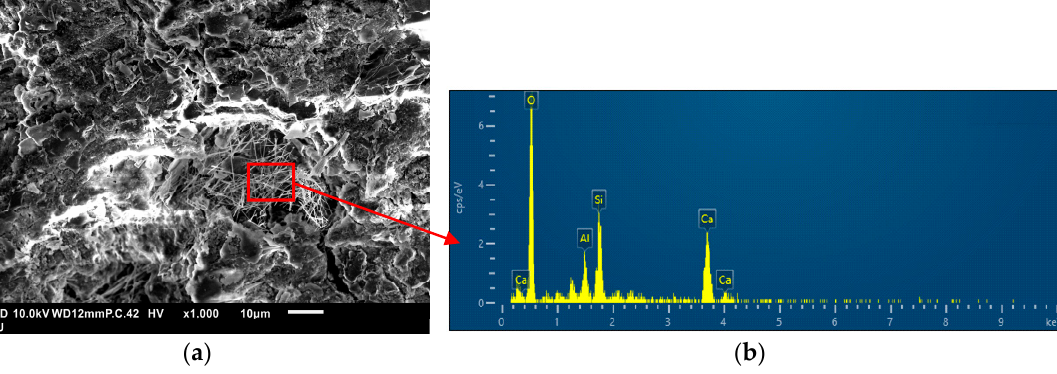
Figure 10. scanning electron microscope (SEM) photos with energy dispersive analysis (EDS) analysis: ( a ) S60 specimens; ( b ) EDS results.